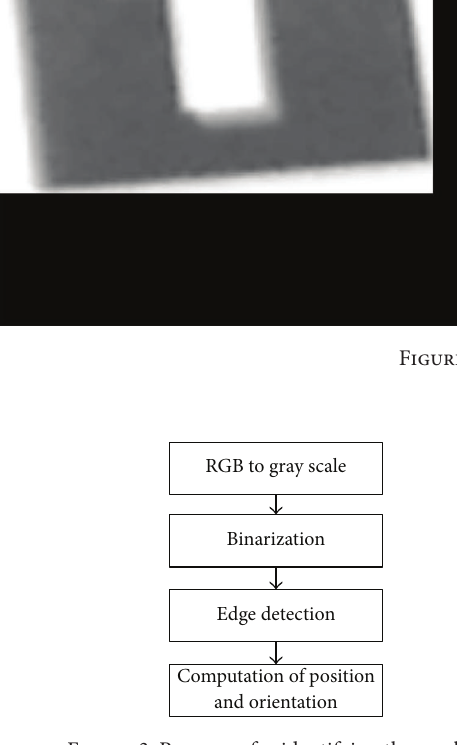
Figure 3: Processes for identifying the marker.